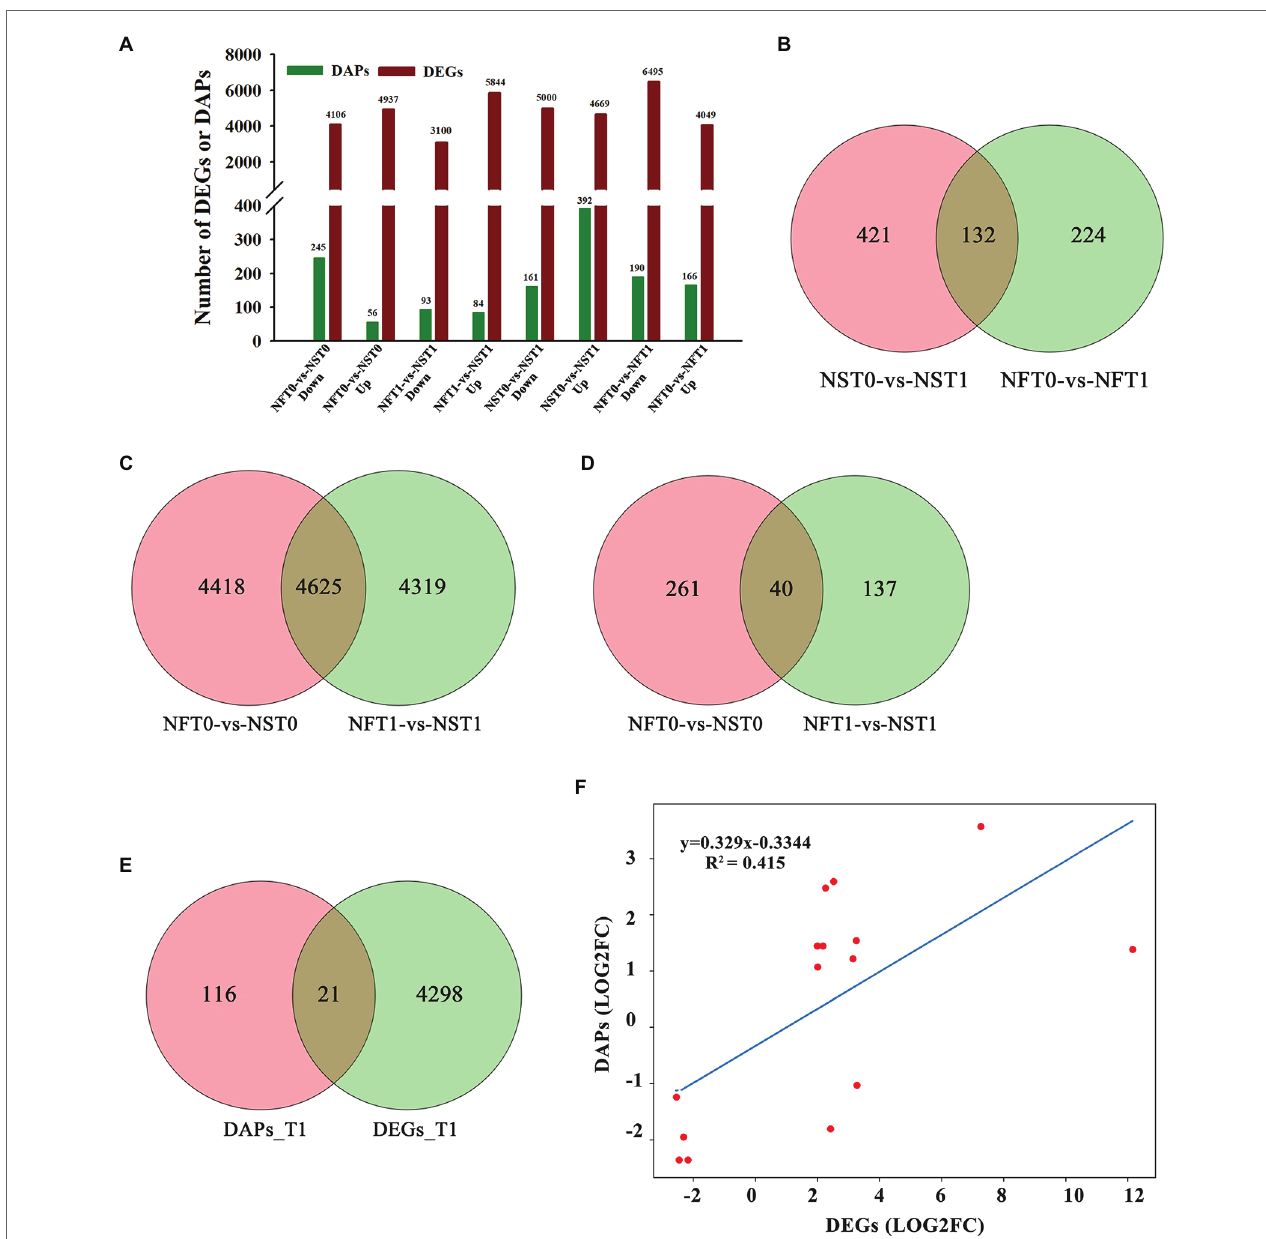
FIGURE 4 | Comparison of transcript and protein abundance in developing rapeseed leaves. (A) The number of differentially expressed genes (DEGs) and differentially abundant proteins (DAPs) identified for two treatments in both cultivars. (B) DAPs between the control and freezing-stressed leaves in both cultivars. DEGs (C) and DAPs (D) identified in the leaf between both cultivars under freezing stress, respectively. (E) Venn diagram of the unique DEGs and DAPs between both cultivars at freezing treatment time of T1. (F) Concordance changes between DEGs and the encoded DAPs between both cultivars at freezing treatment time of